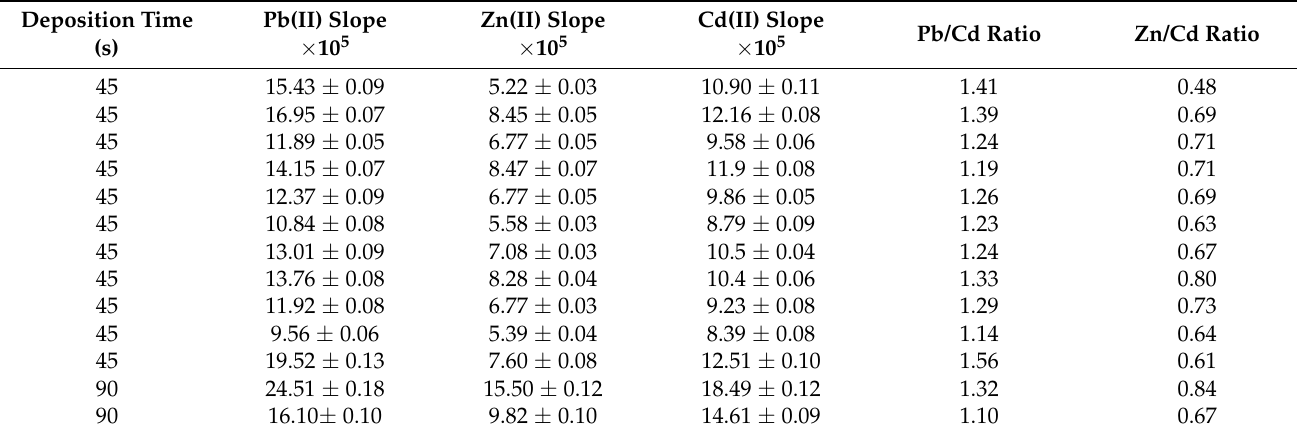
Table 3. SCP slopes with standard error and respective slope ratio values for Pb(II), Zn(II) and Cd(II) at 0.1 M NaNO 3 , pH